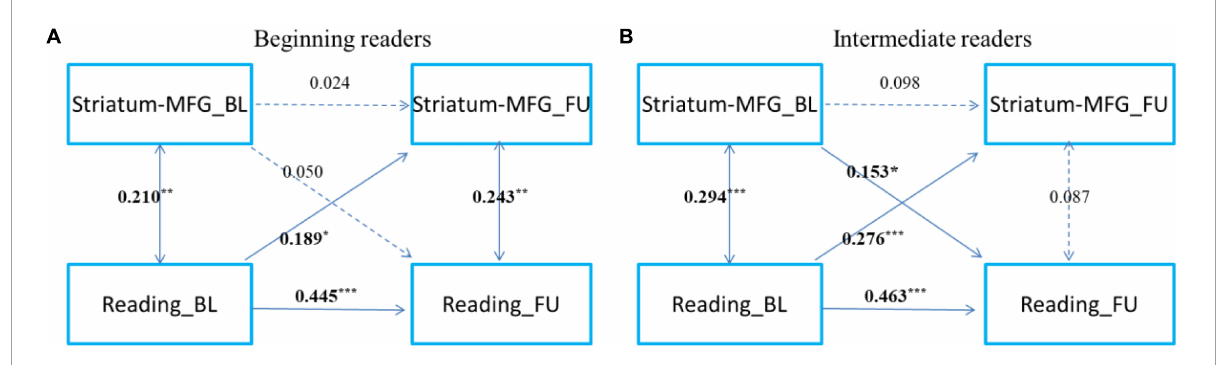
FIGURE3 The cross-time predictions between left striatum and left middle frontal gyrus functional connectivity and reading development in school-age children The cross-lagged panel models in (A) beginning readers (grade 3 and below), and (B) intermediate readers (grade 4 and above). Standardized estimates are presented. MFG, middle frontal gyrus. Age, sex, handedness, site, household income, parental education, and head motion were used as covariates of no interest. * p < 0.05, ** p < 0.01, *** p < 0.001.